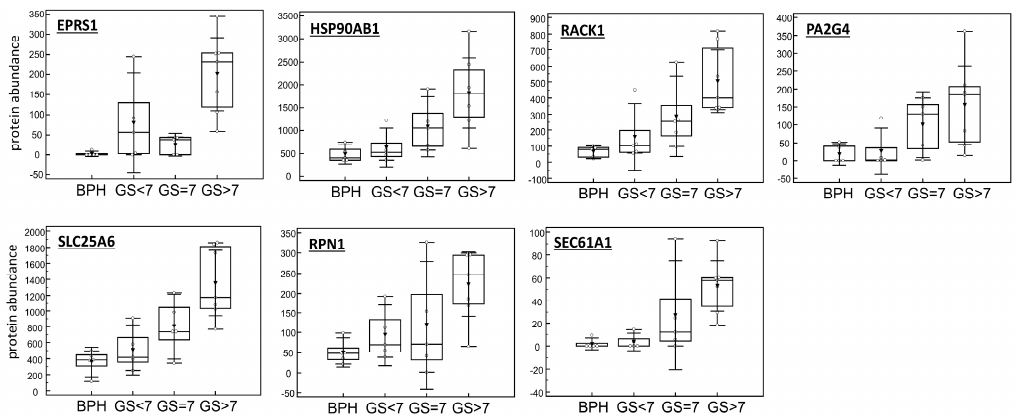
Figure 4. Boxplots representing distribution of the normalized protein abundance according to the